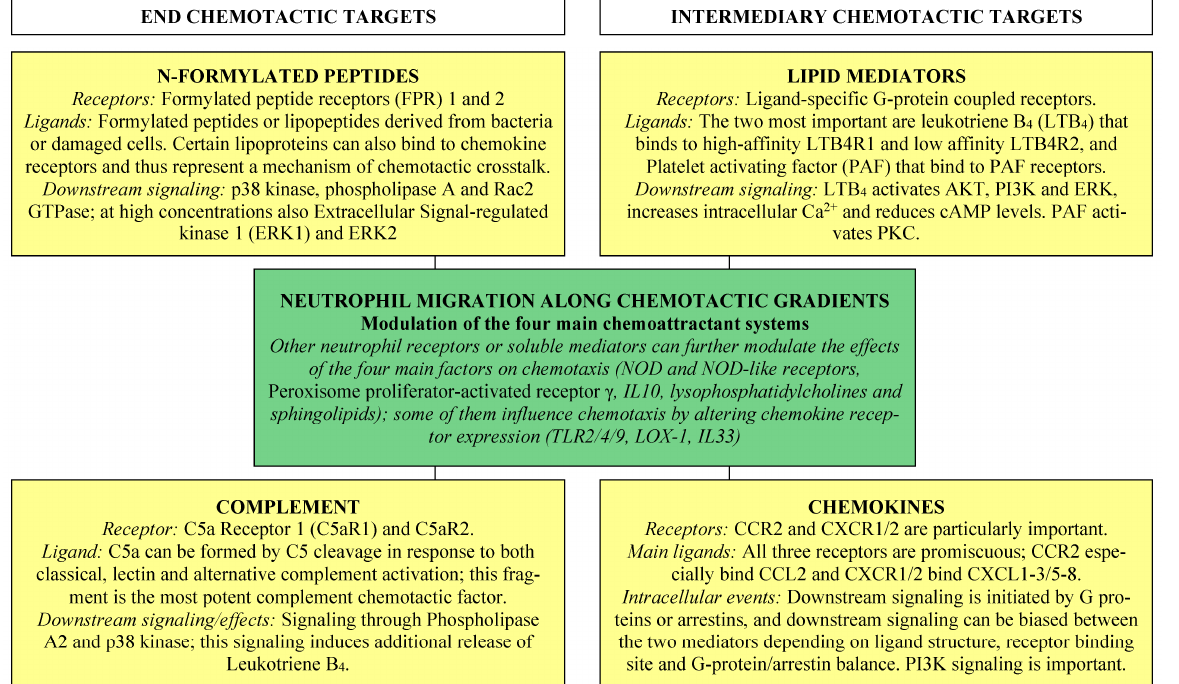
Figure 1. An overview of the classification and important characteristics of the four (see the yellow boxes) main neutrophil chemoattractants (for a detailed discussion with references see Section